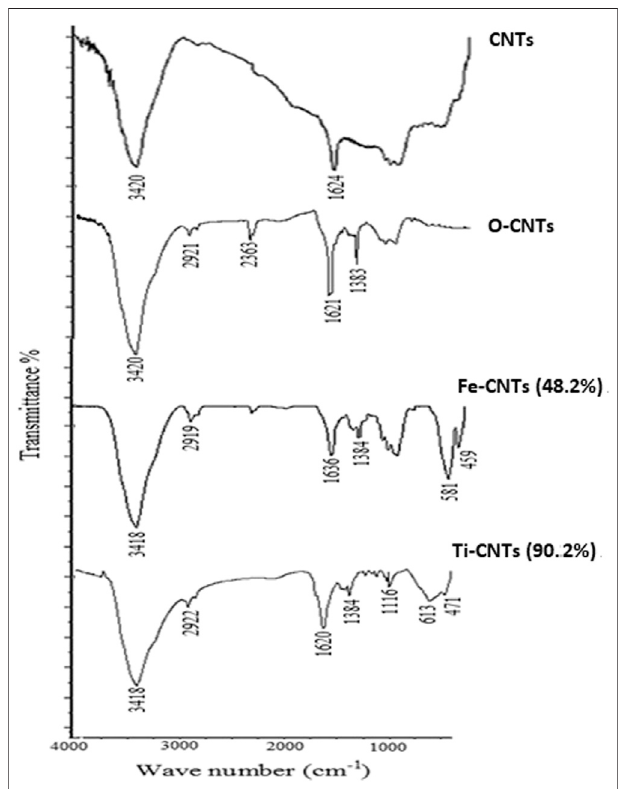
FIGURE 1 | IR spectra of oxides-loaded-CNTs beside original